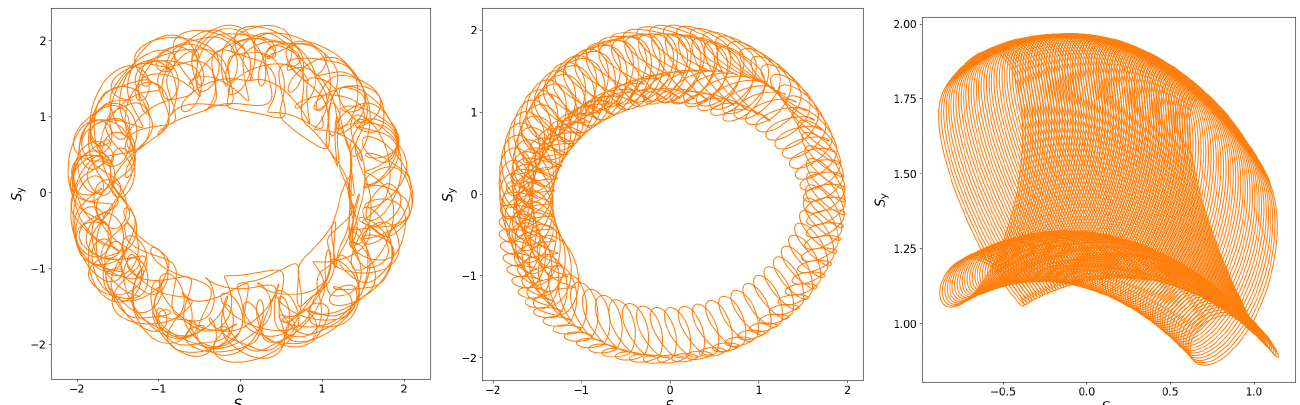
Figure 4. Precession and nutation of the MSP spin for a MSP in 100 quasi-circular orbits around a Kerr BH with a / M = 0.998. The semi-major axes of the MSP orbits are r / M = 10, 100 and 1000 (from left to right ). Adopted from Kimpson, Wu and Zane